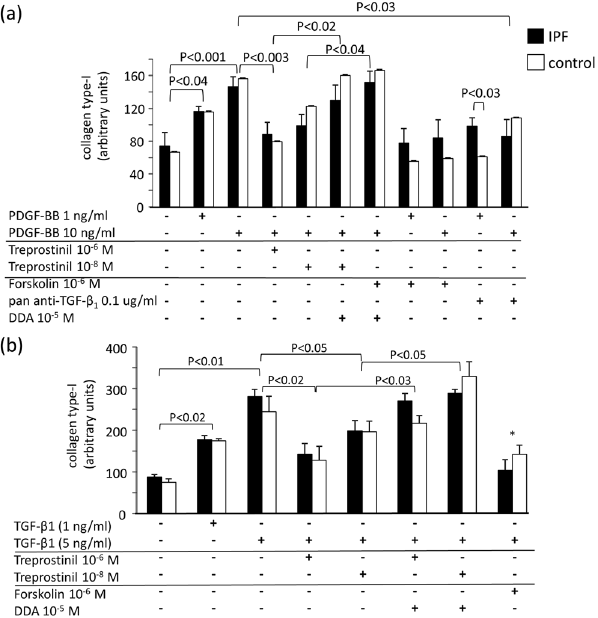
Figure 4. ( a ) Treprostinil inhibits PDGF-BB induced collagen type-I deposition through TGF- β 1 and cAMP. ( b ) Treprostinil inhibits TGF- β 1 induced collagen type-I deposition through cAMP signaling. Bars show the mean ± S.E.M. of triplicated experiments all primary control and IPF cell lines. Statistics: Mann-Whitney